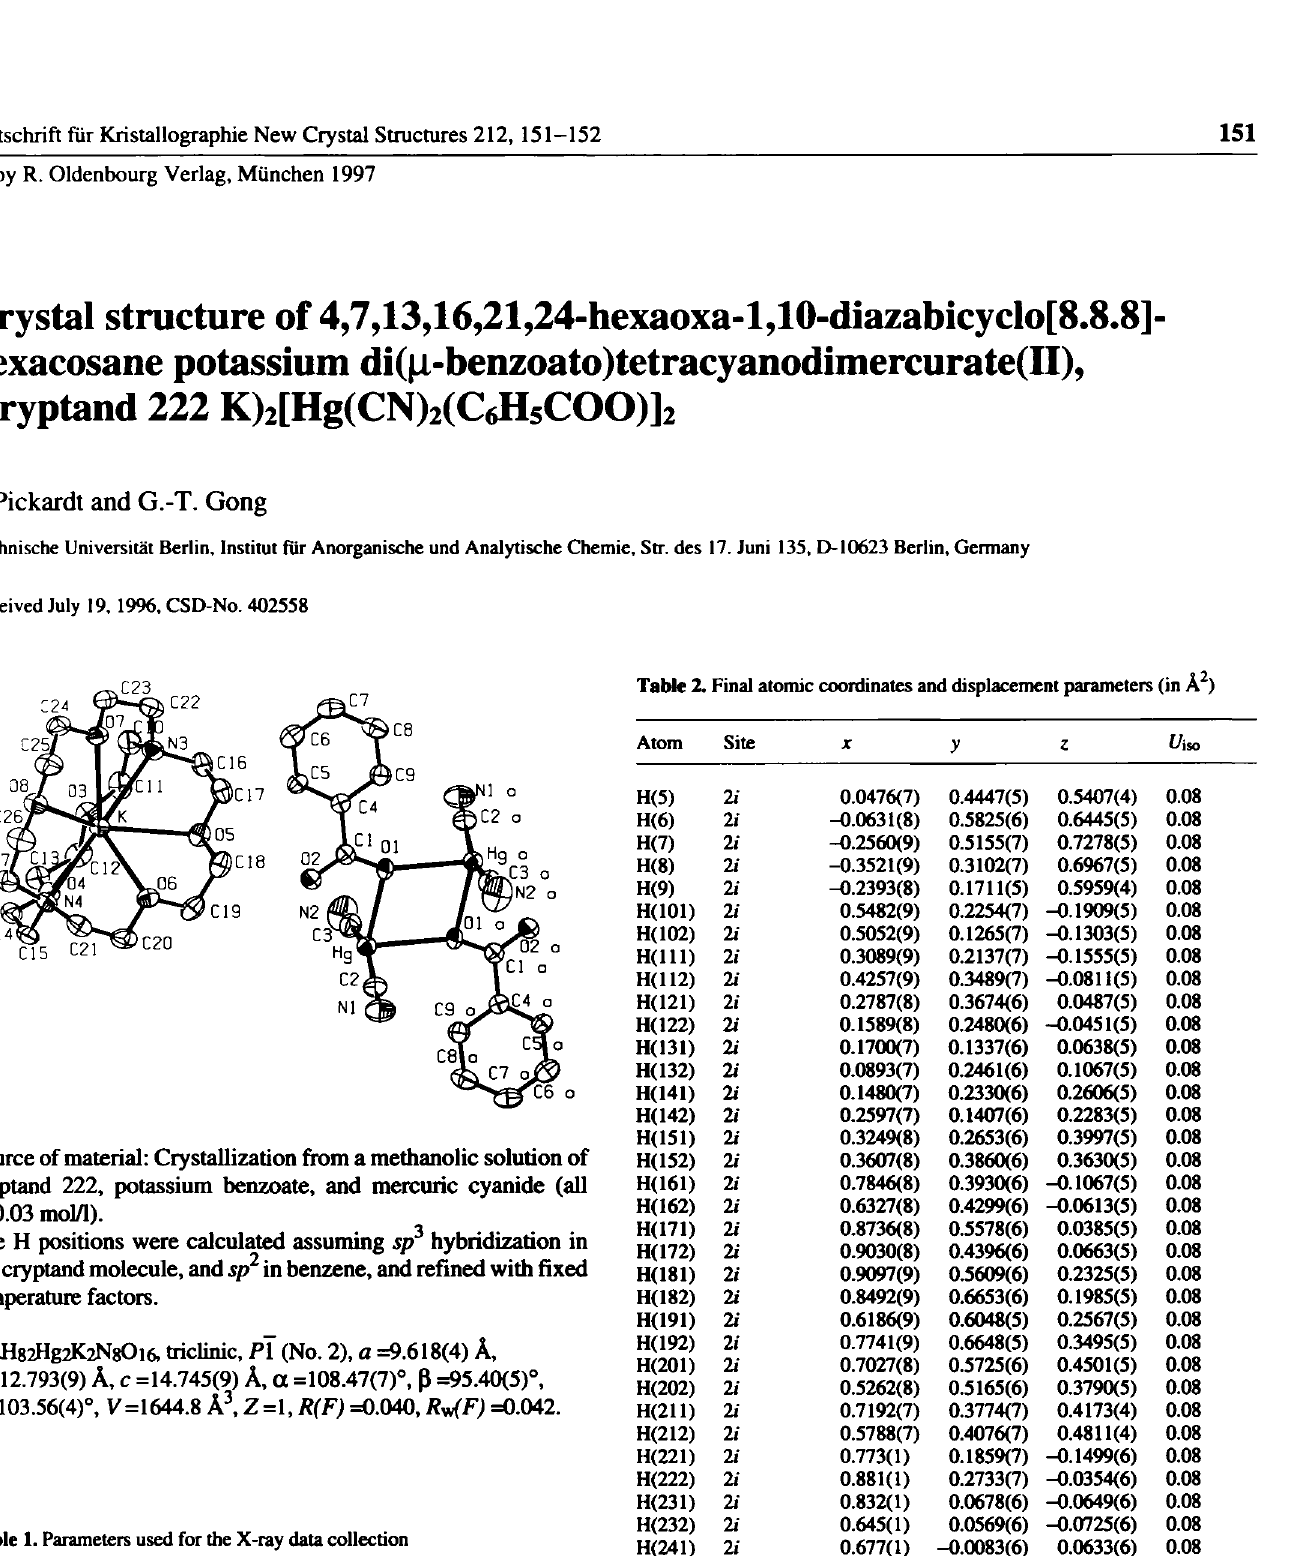
Table 1. Parameters used for the X-ray data collection Crystal: